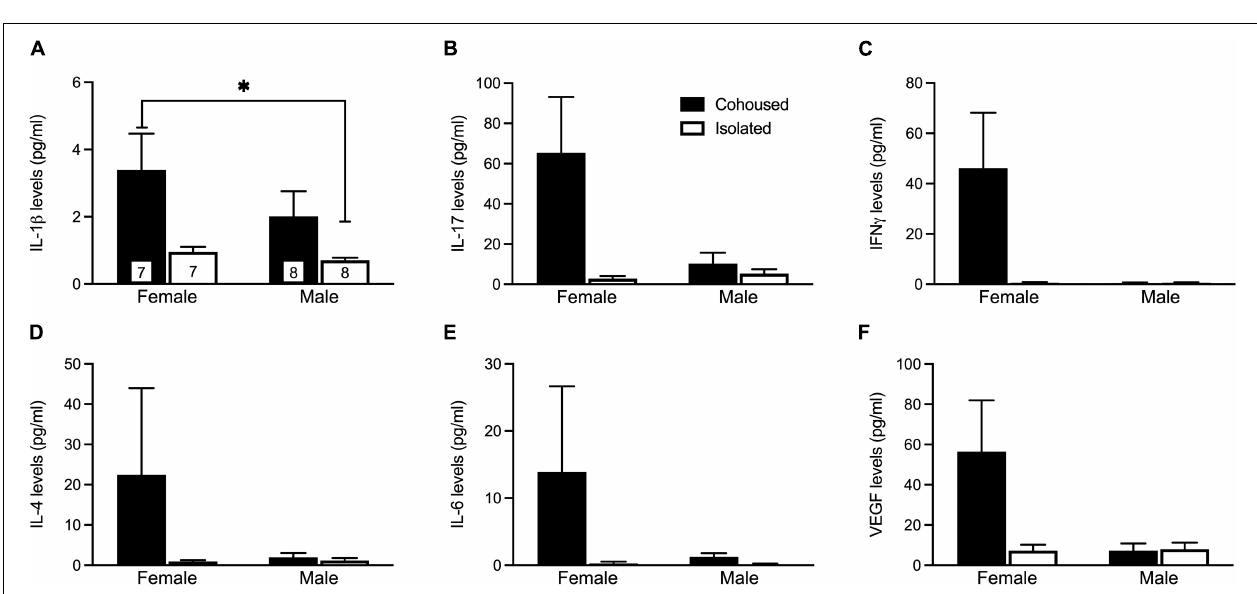
FIGURE 1 | Post-weaning isolation effects on elevated plus maze (EPM) (A) and forced swim test (FST) (B) behaviors. Six weeks of post-weaning social isolation did not affect the duration on the open arms nor the frequency of open arm entries on the EPM in male and female prairie voles. Females displayed higher levels of overall locomotor activity during the EPM test in comparison to male prairie voles. In the FST, post-weaning social isolation did not affect the duration of immobility in male and female prairie voles. Male prairie voles had significantly lower latency to immobility compared to females, and socially isolated animals had higher overall levels of activity in comparison to cohoused animals. Bars indicate mean ± SEM. The number within each bar on (A) indicates the number of animals for each group. * represents p < 0.05.